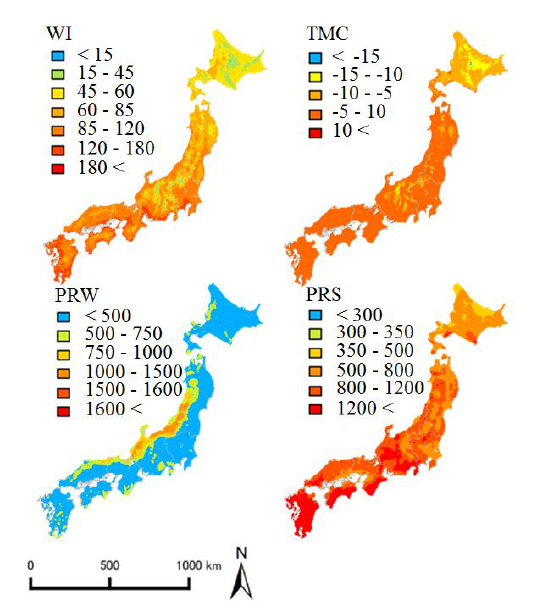
Figure 3. Distribution of present climatic